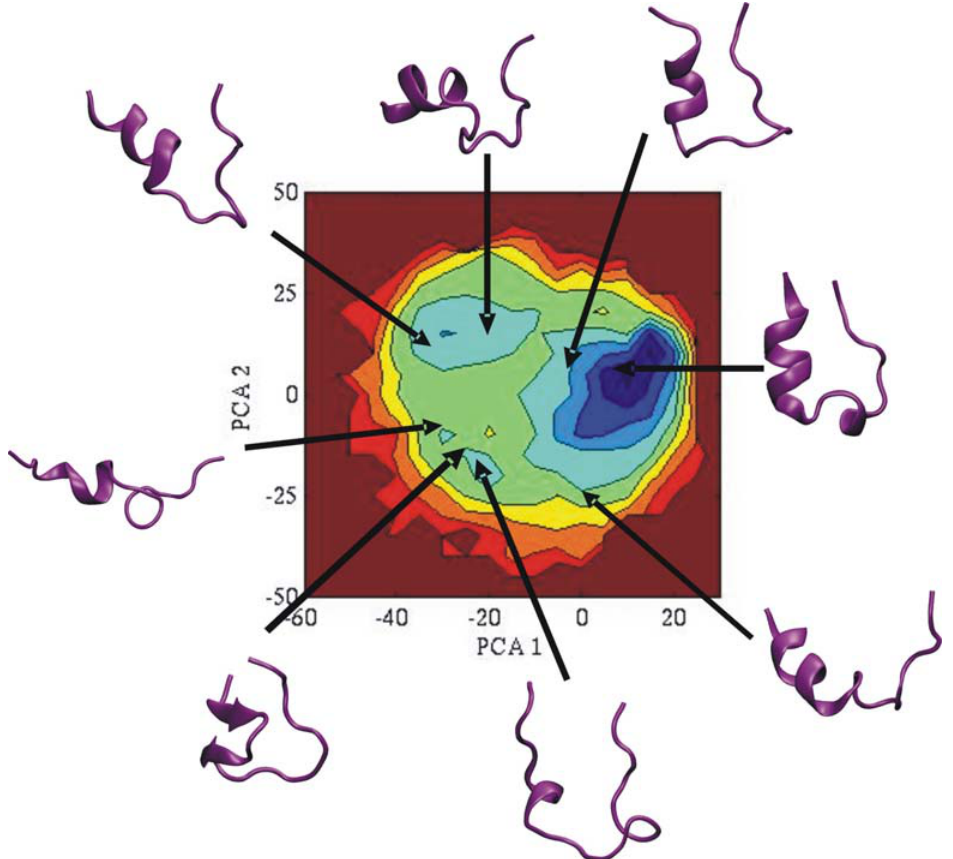
Figure 5. Mapping of representative Trp-cage conformations on populated regions in the 2D plane spanned by the two principal components with largest eigenvalue of the C α positional covariance matrix (obtained from the BP-RexMD simulation). Trp-cage structures are shown as cartoon